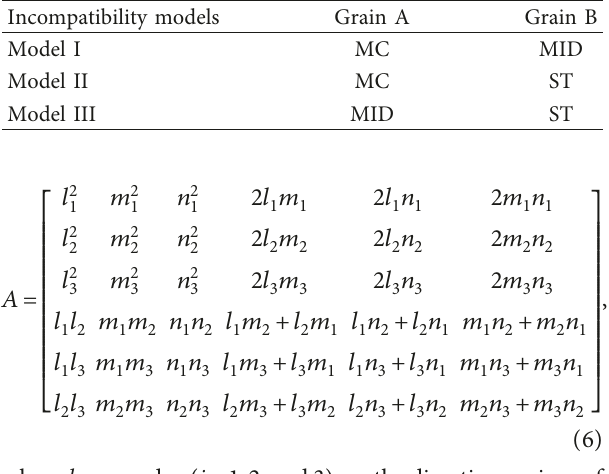
Table 2: Incompatibility bicrystal models with three types of GBs. Incompatibility models